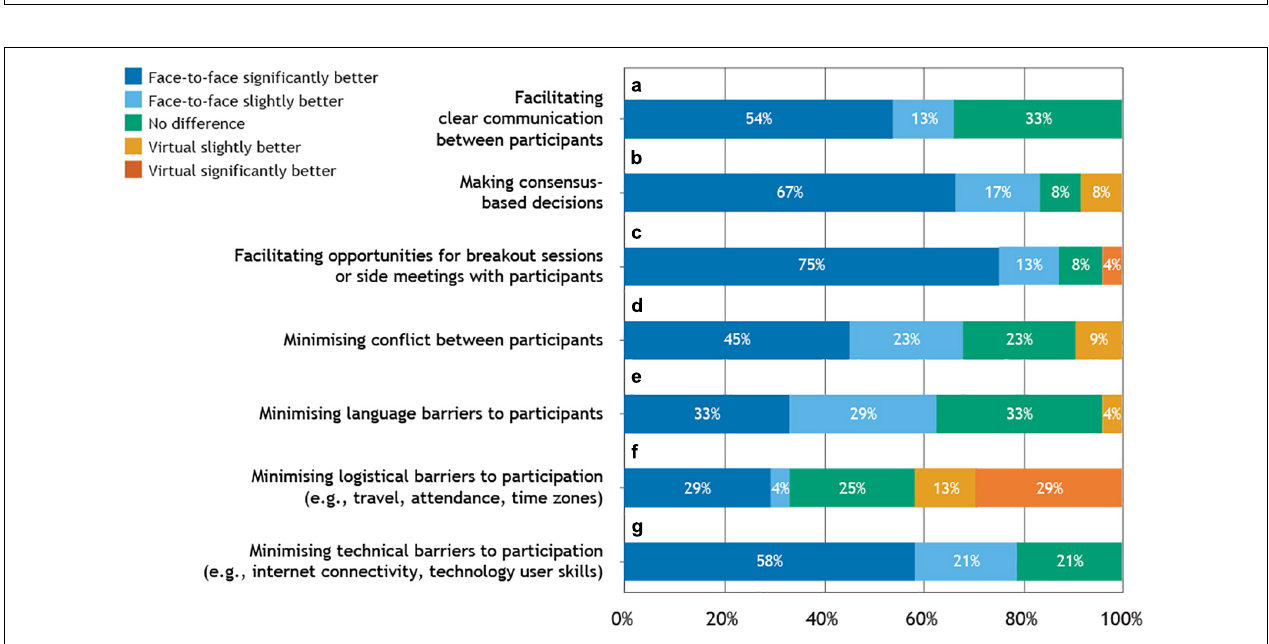
FIGURE 3 | Responses ( n = 24) to How would you rate the meeting formats (face-to-face or virtual) at supporting the following meeting